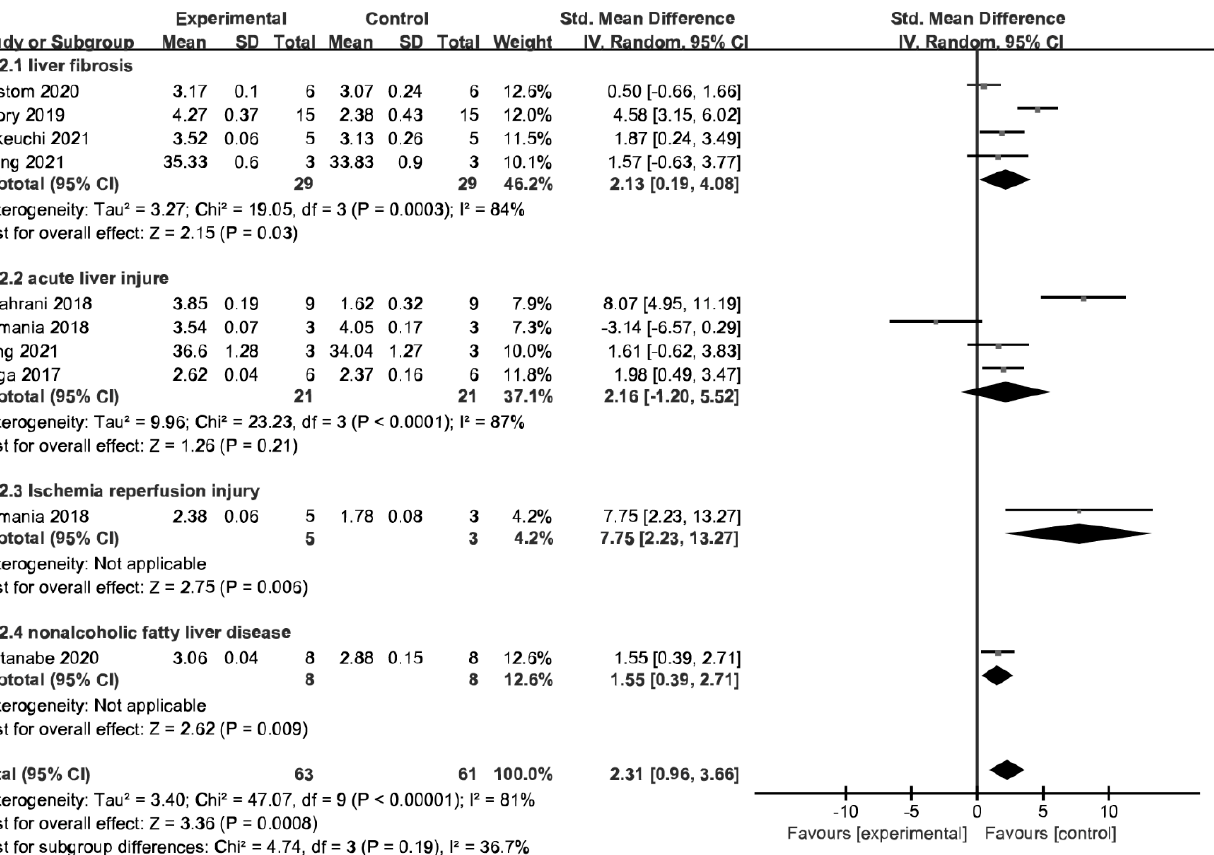
Figure 2. Forest plot of the efficacy of MSC-EV therapy on liver function, albumin (ALB). Serum ALT was evaluated in 35 studies (36 comparisons) and serum AST in 28 studies (30 comparisons). The pooled analysis showed that MSC-EV lowered the ALT level